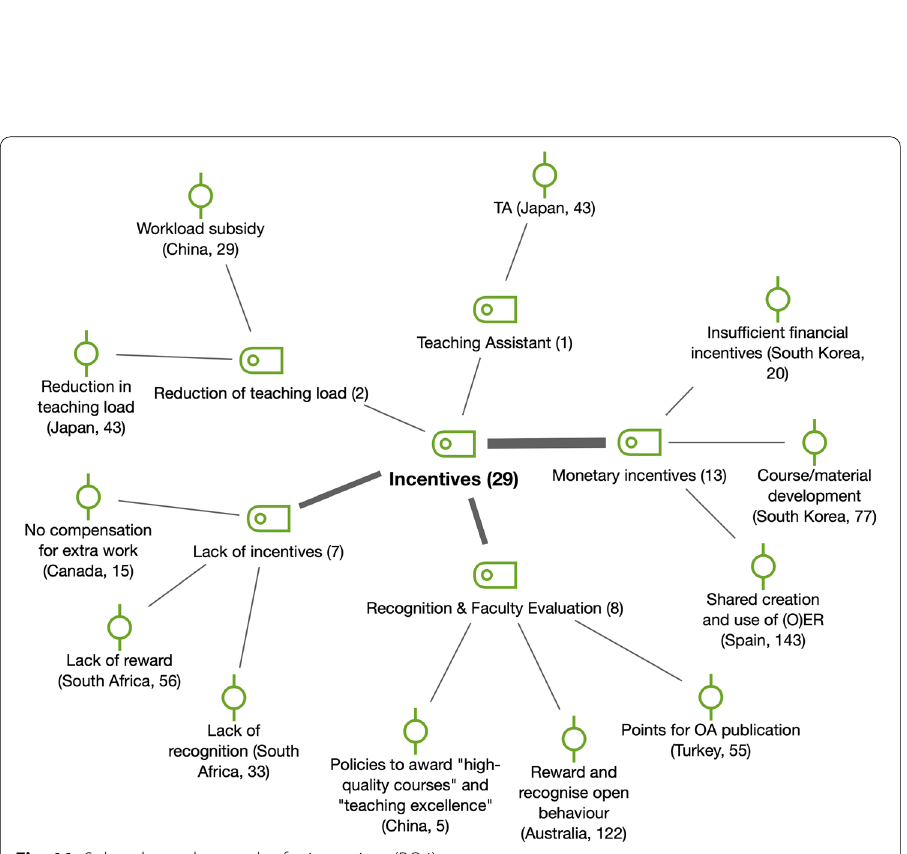
Fig. 11 Subcodes and examples for incentives